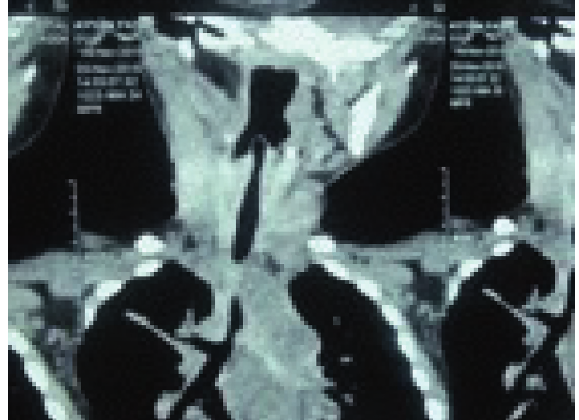
Figure 2: Preop coronal CT appearance in a child with acquired subglottic stenosis.